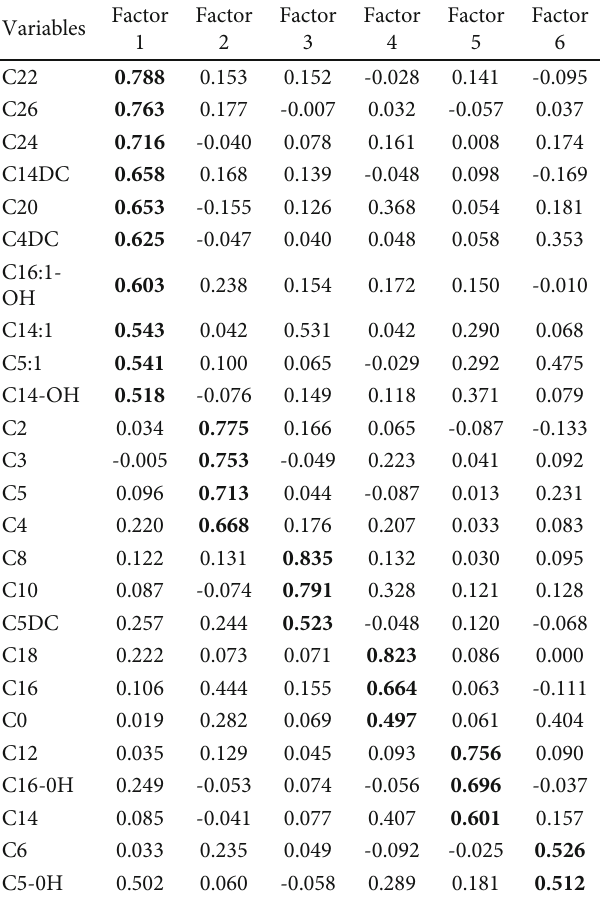
Table 3: Factor analysis of 25 acylcarnitines resulted in factors and the postrotation load of each factor.